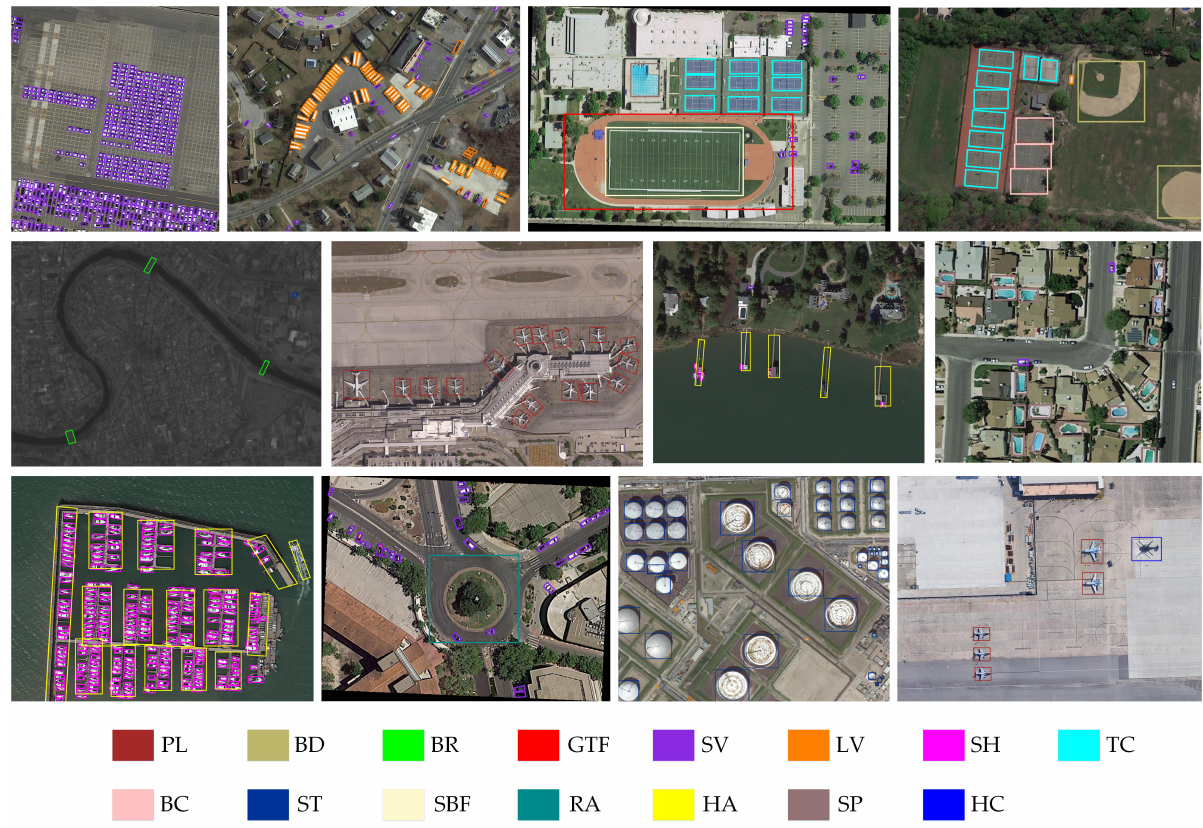
Figure 6. The visualized detection results on DOTA.